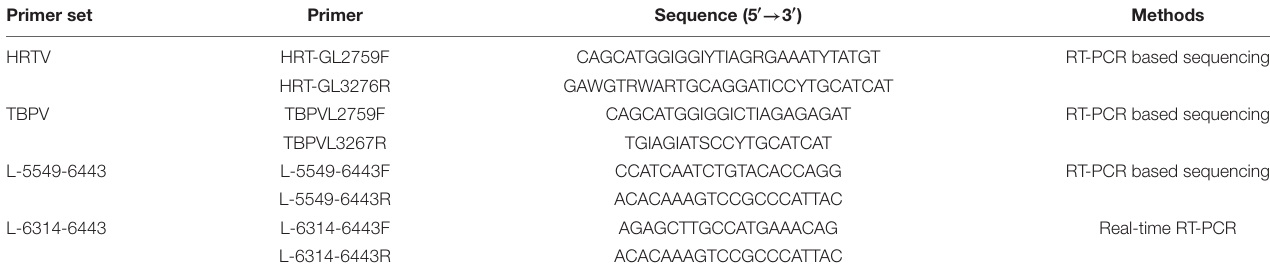
TABLE 2 | Primers used in the RT-PCR for MKWV detection. Primer